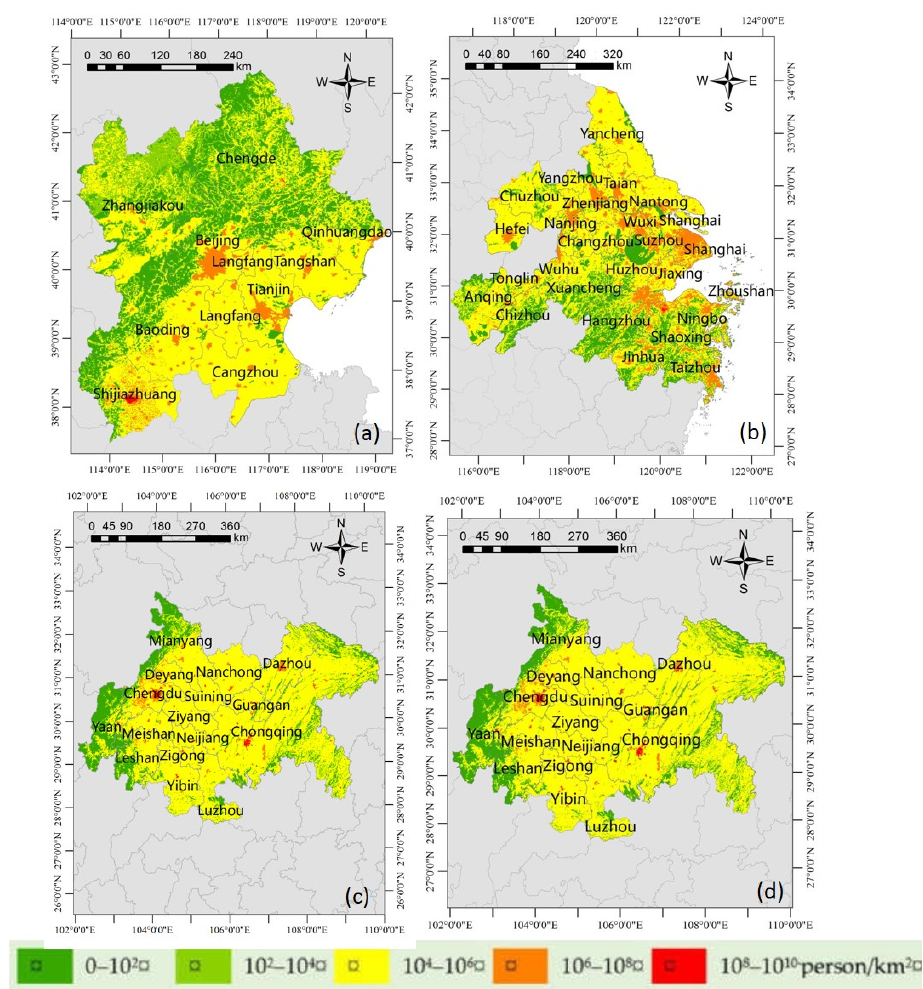
Figure 3. The population exposure to PM 2.5 in the four urban agglomerations. ( a ) Beijing ‐ Tianjin ‐ Hebei; ( b ) Yangtze River delta; ( c ) Pearl River delta; and ( d ) Chengdu ‐ Chongqing.